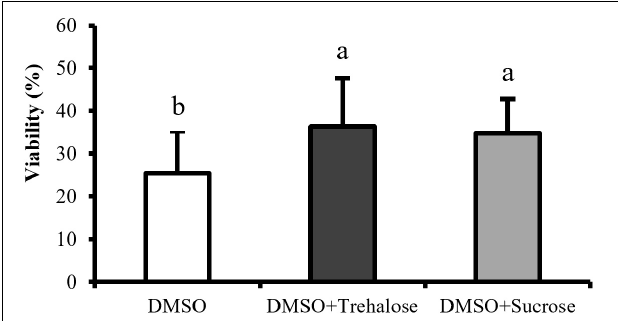
FIGURE 4 | Plasma membrane integrity of C. angulata sperm frozen with 10% DMSO (white bar) and 10% DMSO supplemented with 0.45 M trehalose (black bar) or sucrose (gray bar) evaluated by flow cytometry. Results were expressed in mean percentages ± SD ( n = 10). Different letters show differences between cryoprotectant solutions (one-way ANOVA followed by SNK as post hoc test; p <